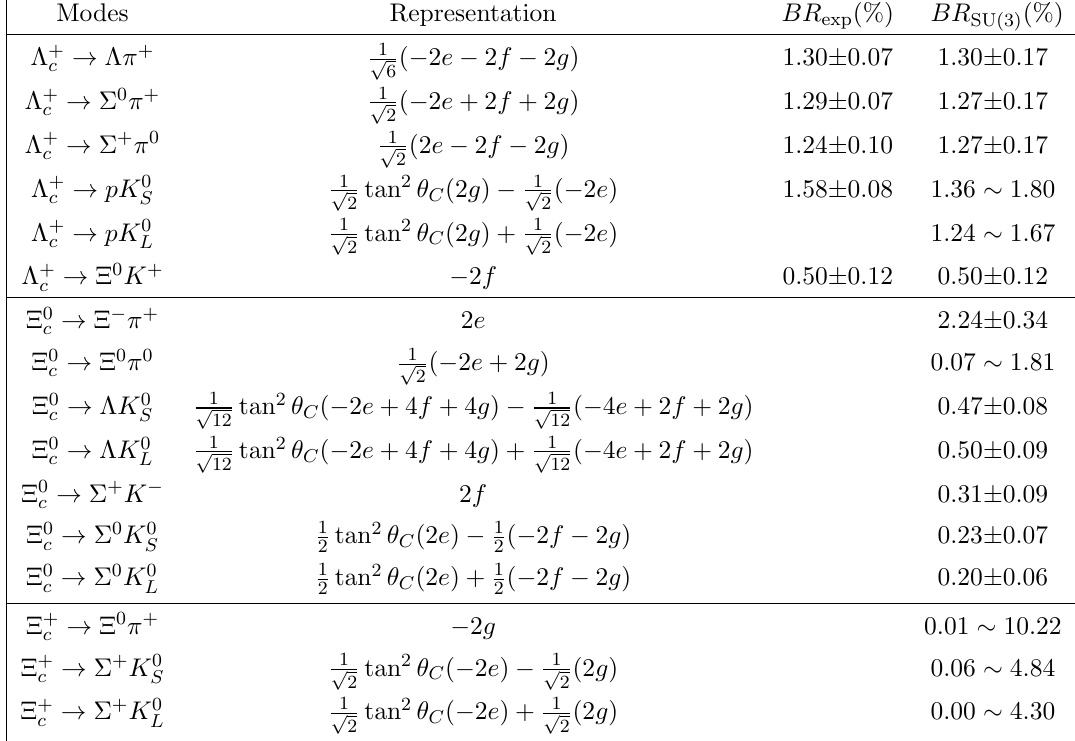
Table 1 . Branching fractions and amplitude representations for the Cabibbo-favored charmed baryon decays. For the modes with neutral kaons K 0 in the (cid:12)nal states, the associated doubly S;L Cabibbo-suppressed amplitudes are taken into account with the factor of tan 2 (cid:18) C . The ratio of BR ((cid:4) 0 ! (cid:3) K 0 ) =BR ((cid:4) 0 ! (cid:4) (cid:0) (cid:25) + ) = 0 : 210 (cid:6) 0 : 028 is also included in the global (cid:12)t. Our results c c S are given in the last column, compared to the experimental data